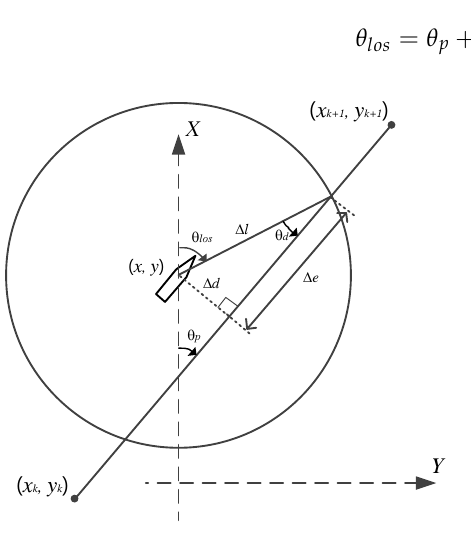
Figure 7. Line-of-sight guidance.